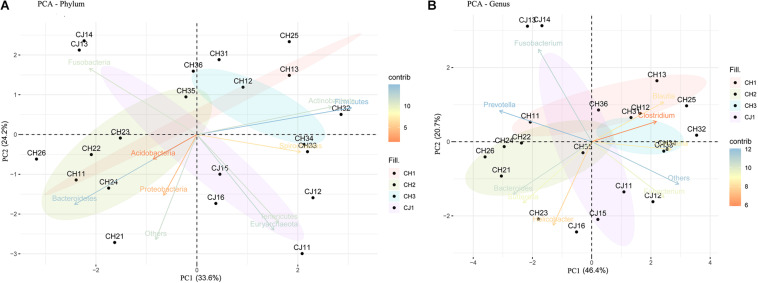
Principal component analysis (PCA) of the fecal bacterial communities on the (A) phylum and (B) genus levels from estrus and non-estrus groups, showing separation among the groups.